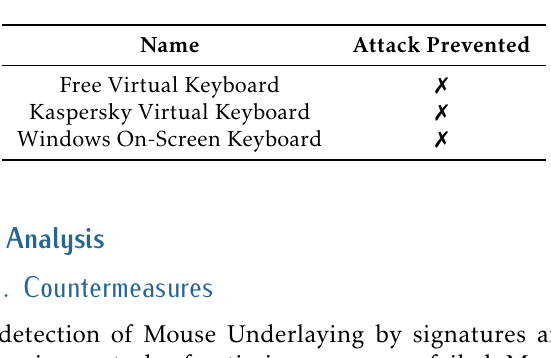
Table 3. Virtual keyboards attempting to prevent keylogging by Mouse